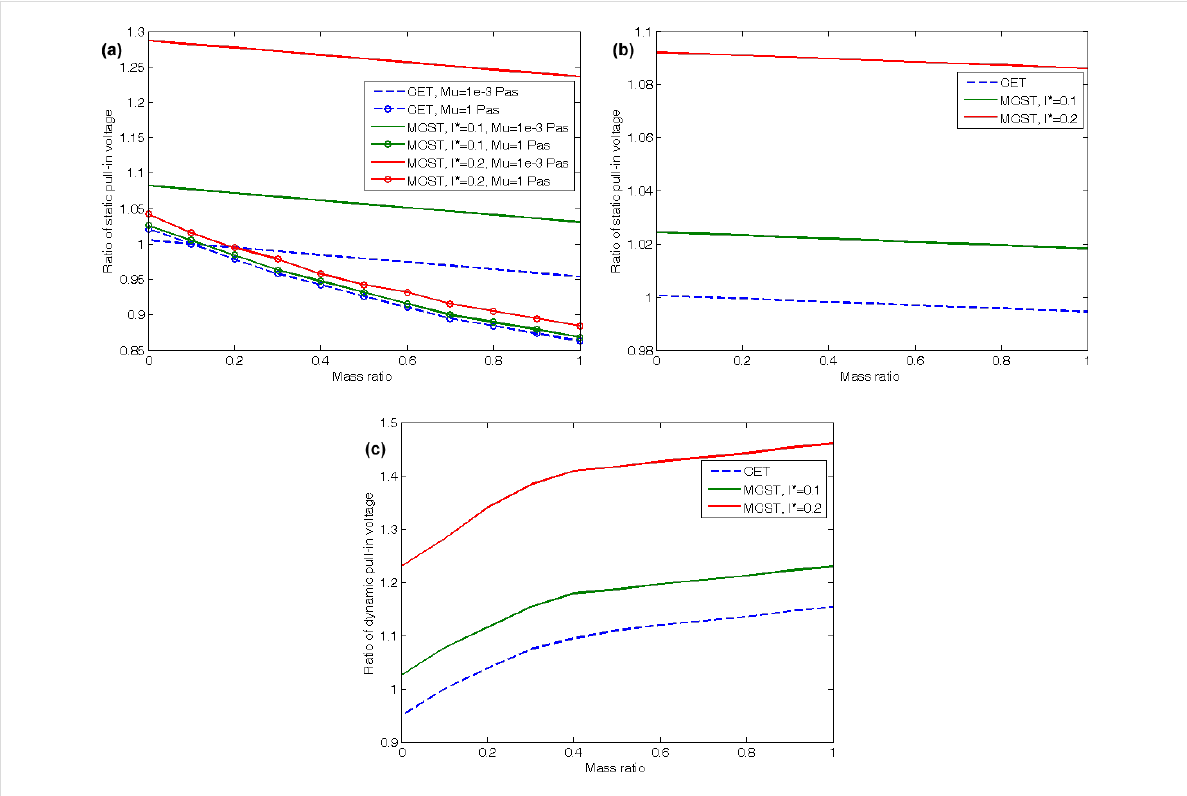
Figure 8: Effects of changes in the mass ratio on (a) the static pull-in voltages of cantilevered CNT, (b) the dynamic pull-in voltages of cantilevered CNT, (c) the static pull-in voltages of doubly clamped